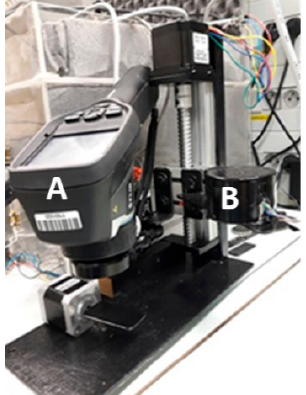
Figure 3. View of the circuit for adjusting the angle of the focus ring ( α k ): A — thermographic camera with close up 2× lens; B — stepper motor to adjust the angle α k .